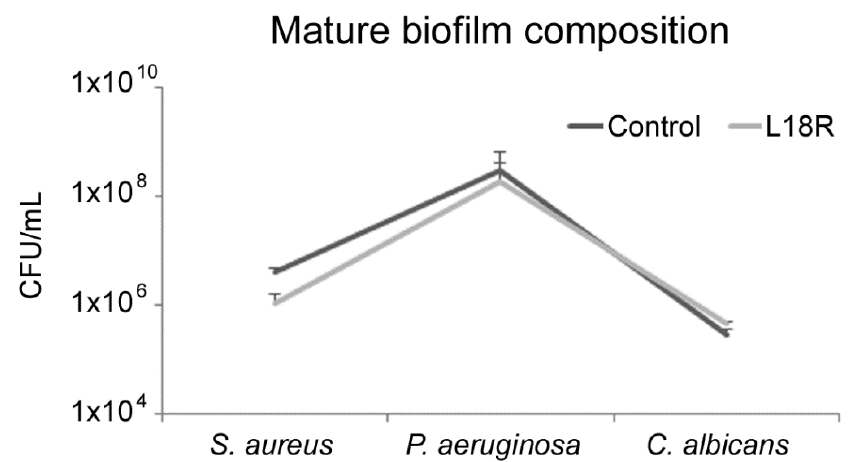
Figure 1. Microbial composition (CFU/mL) of a multispecies mature biofilm (MIX 3) on a polystyrene surface in treated (L18R) and untreated (Control) samples.